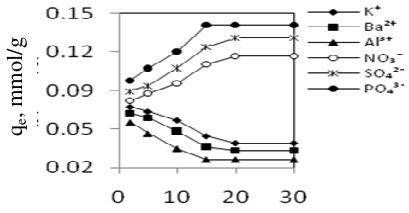
Inogranic ion concentration, µ mol/L Figure 8. Plot of soium-Laurate adsorption in the presence of various inorganic lons at differeent concentrations and charges for